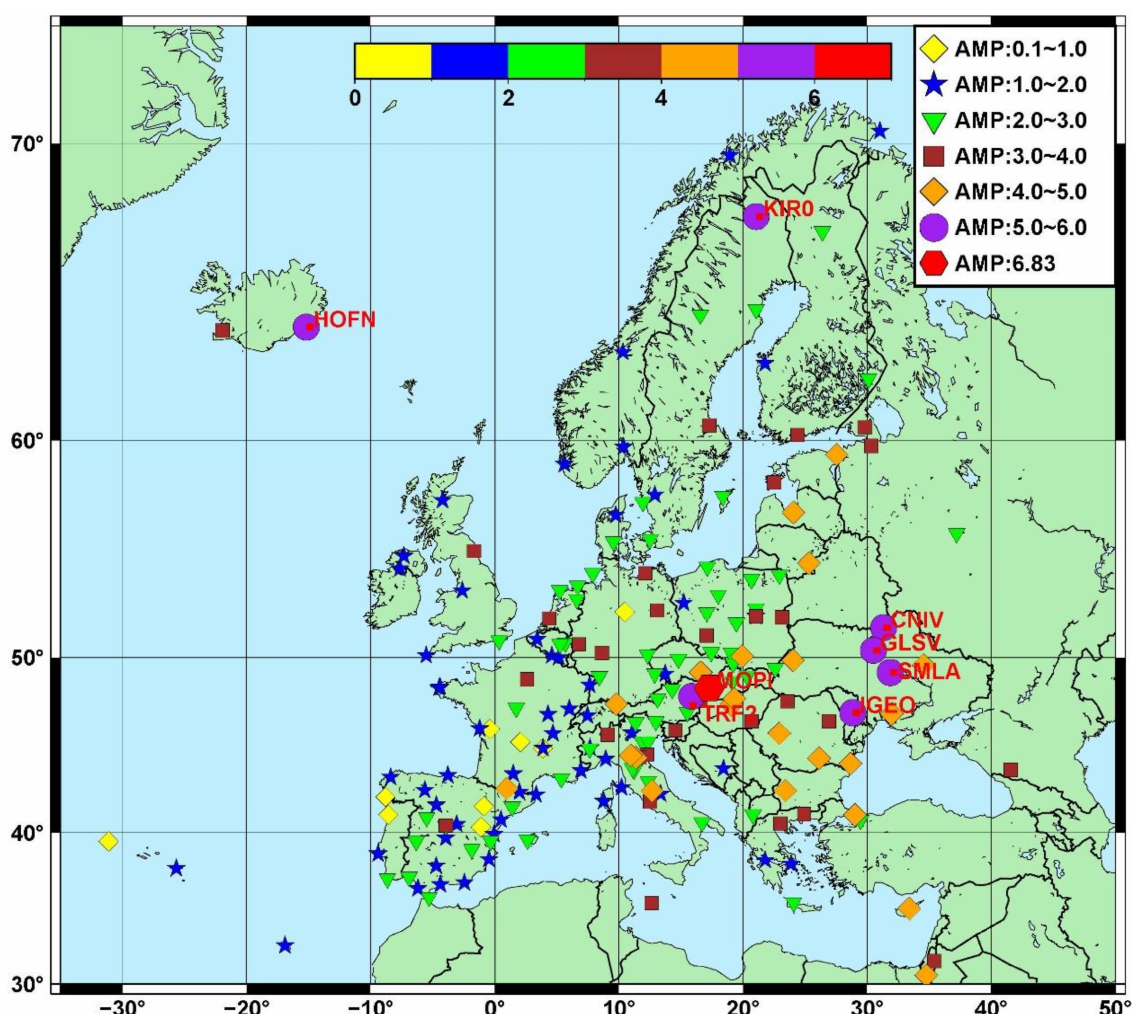
Figure 2. Seasonal amplitude for the Up component of all